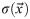
Inferred dispersal surfaces and population density surfaces over time for Europe.We apply MAPS to a European subset of POPRES [25] with 2,234 individuals and plot the inferred dispersal σ(x→) and population density De(x→) surfaces for PSC length bins (a) >1cM (b) 5-10cM and (c) >10cM. We transform estimates of N→ and M to estimates of σ(x→) and De(x→) by scaling the migration rates and population sizes by the grid step-size and area (see Eqs (17) and (18)). Generally, we observe the patterns of dispersal to be relatively constant over time periods, however, we see a sharp increase in population density in the most recent time scale (>10cM). Note the wider plotting limits in inferred densities in the most recent time scale.